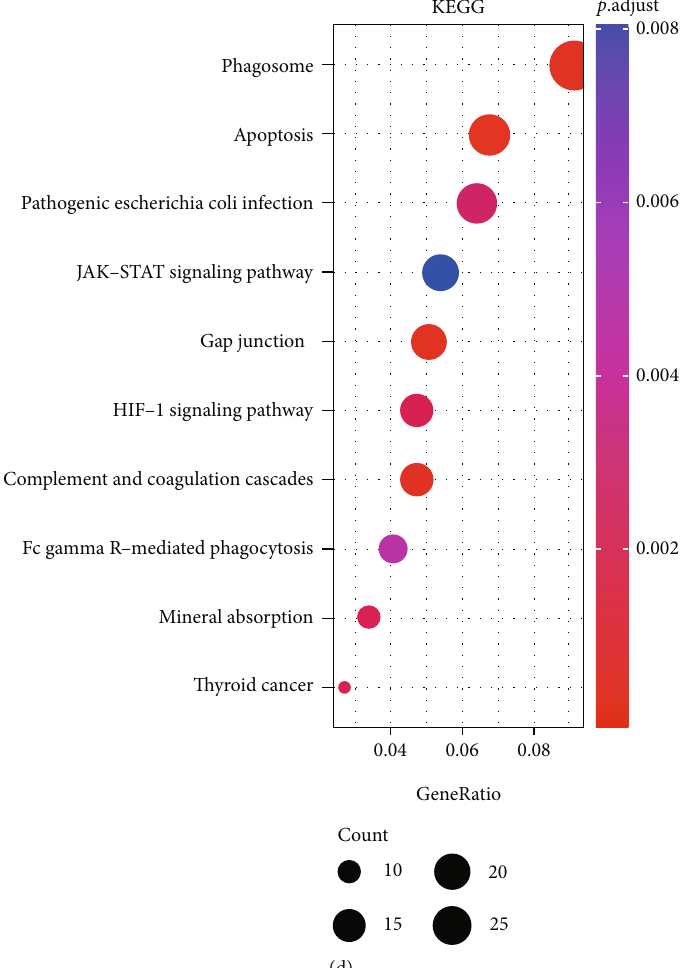
Figure 2: Function and pathway enrichment analyses of DEGs in HCM. (a – c) Signi fi cant Gene Ontology terms of the DEGs, including biological processes (BP), molecular function (MF), and cell component (CC). (d) Signi fi cant KEGG pathways of the DEGs associated with